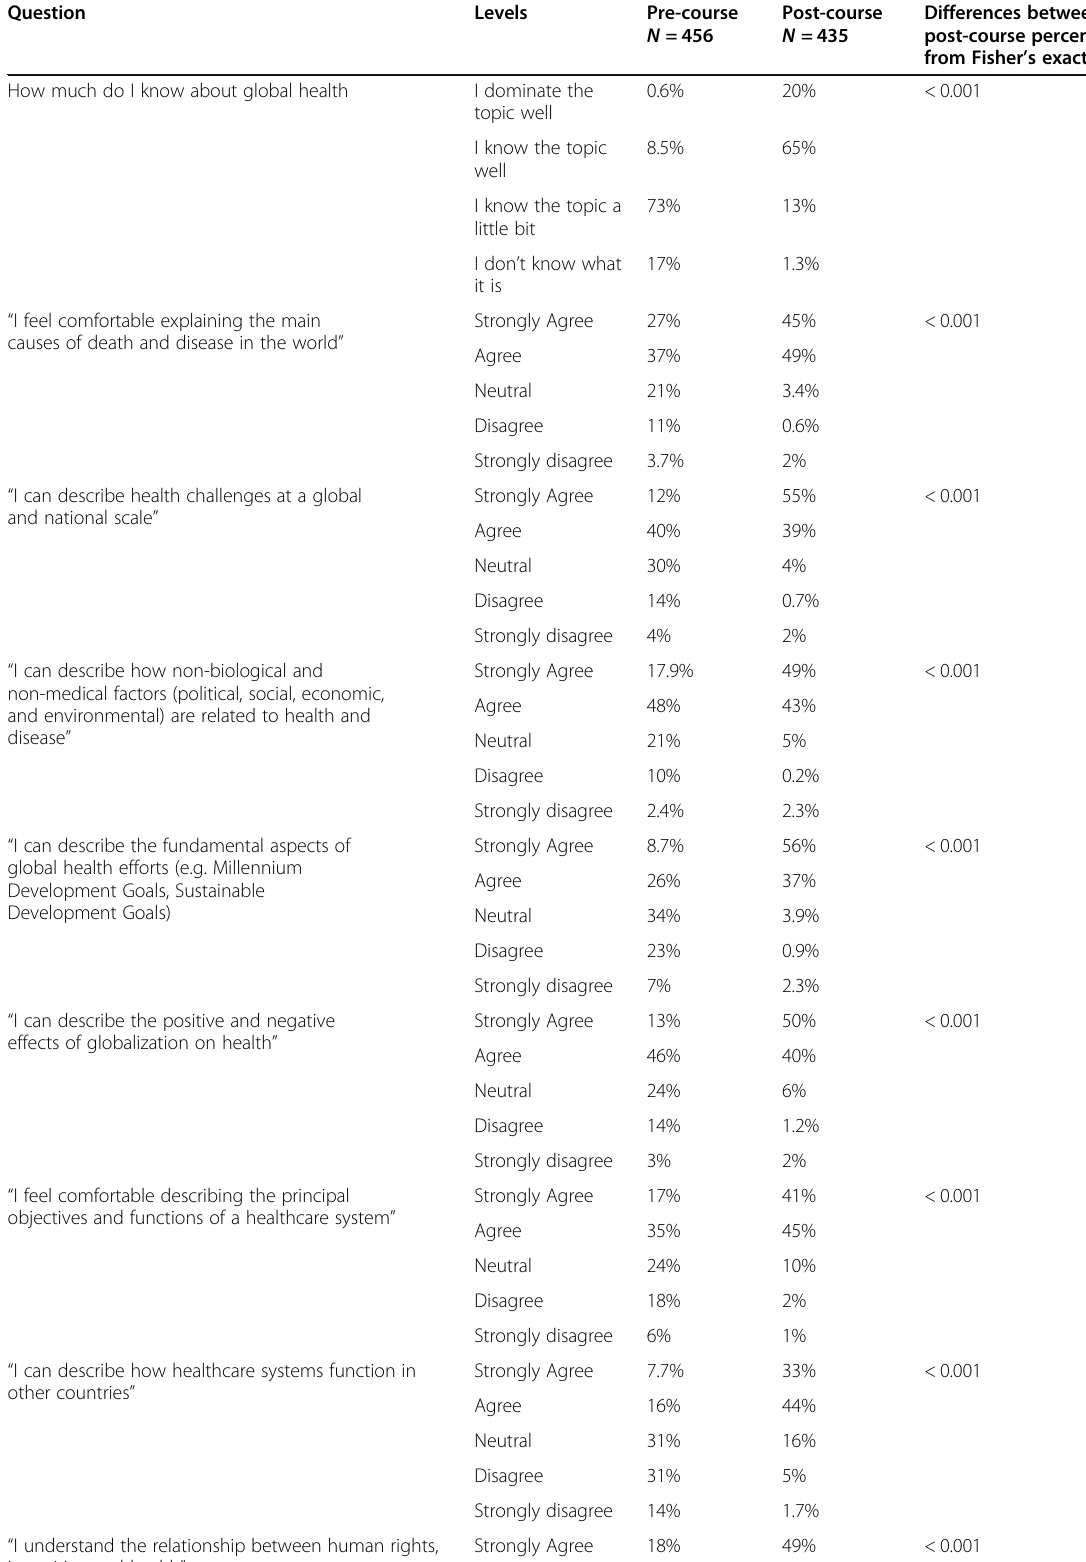
Table 2 Results of self-perceived global health competencies in the pre and post-course survey